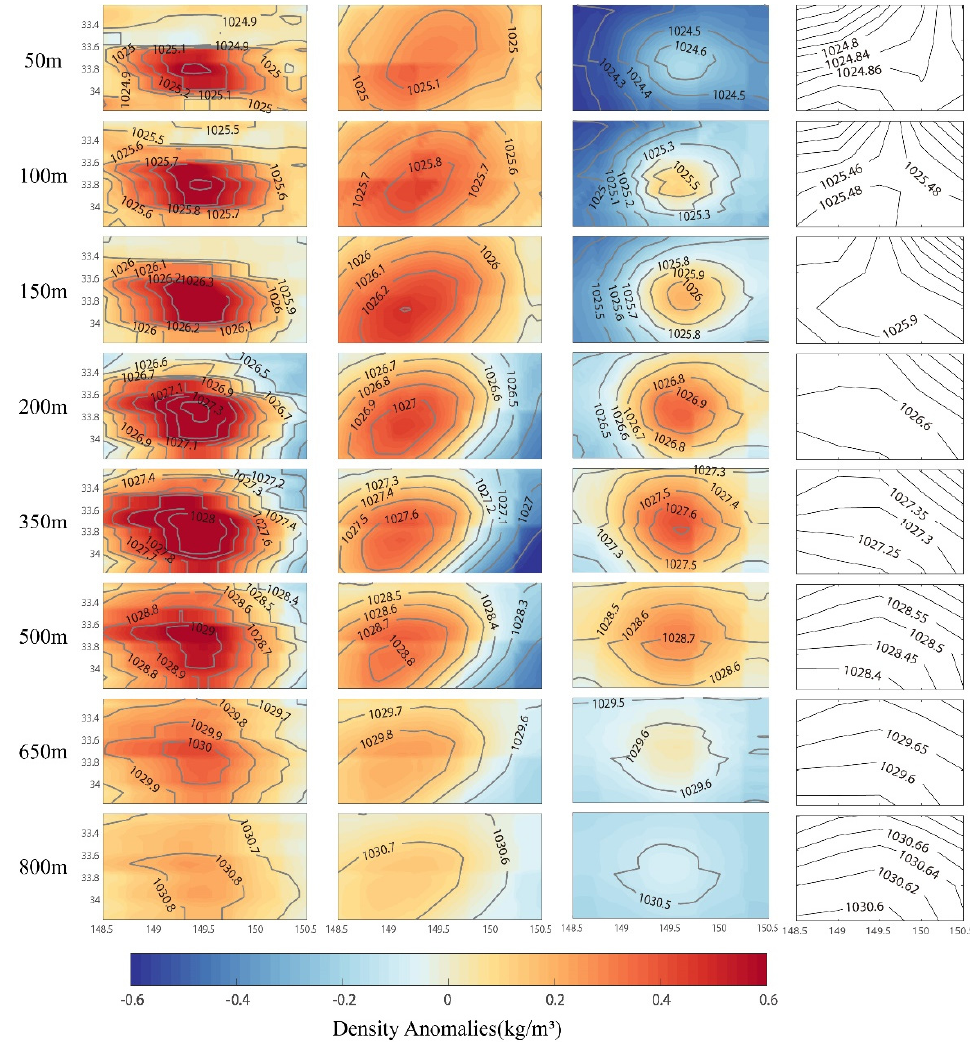
Figure 10. Horizontal distributions of density anomalies at some specific depth layers. The horizontal axis is longitude and vertical axis is latitude. Same as Figure 9.